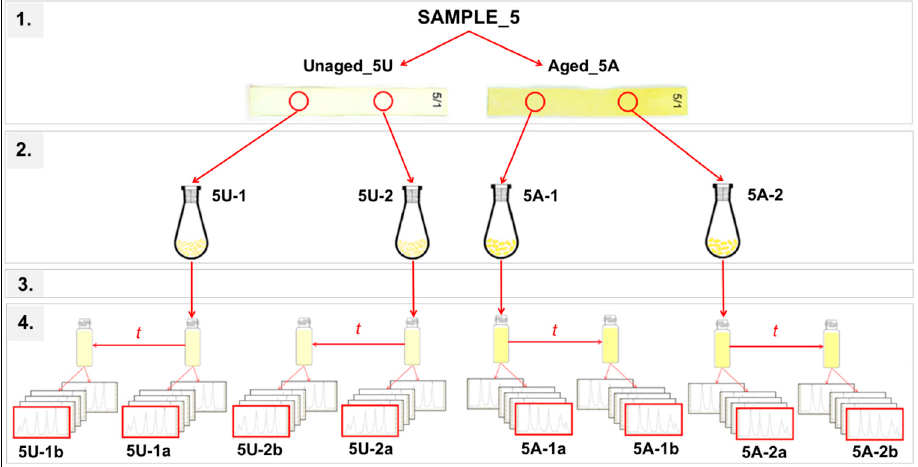
Figure 1. Illustrative overview of three influencing factors (solution, aging, method) on the DP of examined cellulose samples.